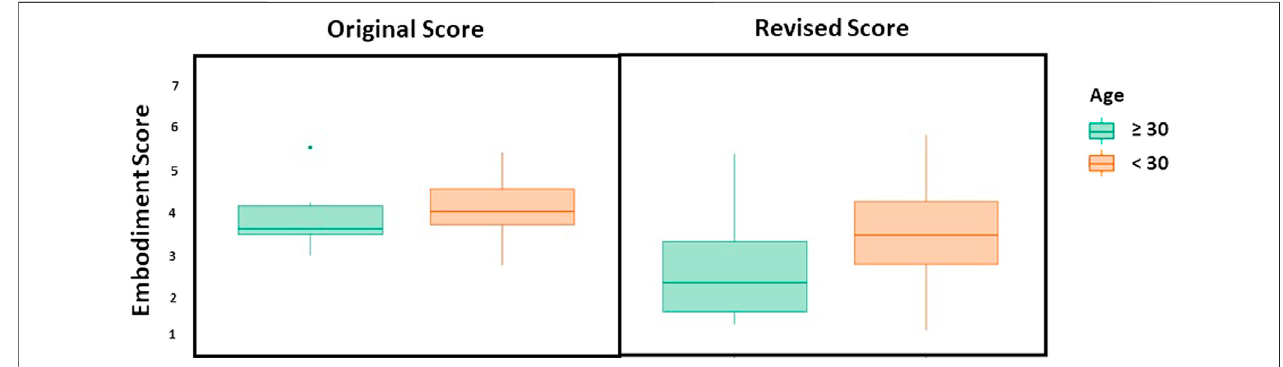
FIGURE 3 | Box-plots of the embodiment scores from study #8 computed with the original and revised questionnaire by participant age group ( ≥ 30: Green and < 30: Orange).